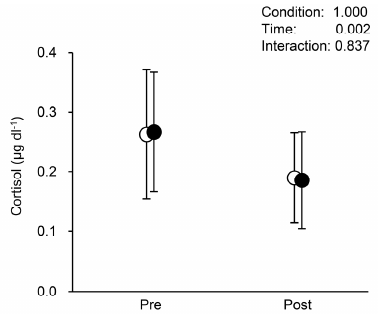
Figure 2. Changes in saliva cortisol, with vs. without stockings. Values are mean ± standard deviation (SD). White circles indicate without stockings and black circles indicate with stockings.